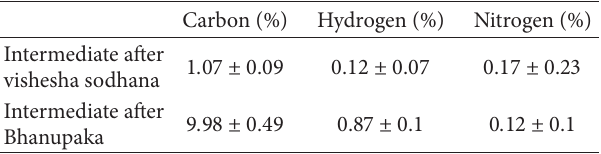
Table 2: Carbon, hydrogen and nitrogen contents in intermediate after vishesha sodhana and the intermediate after